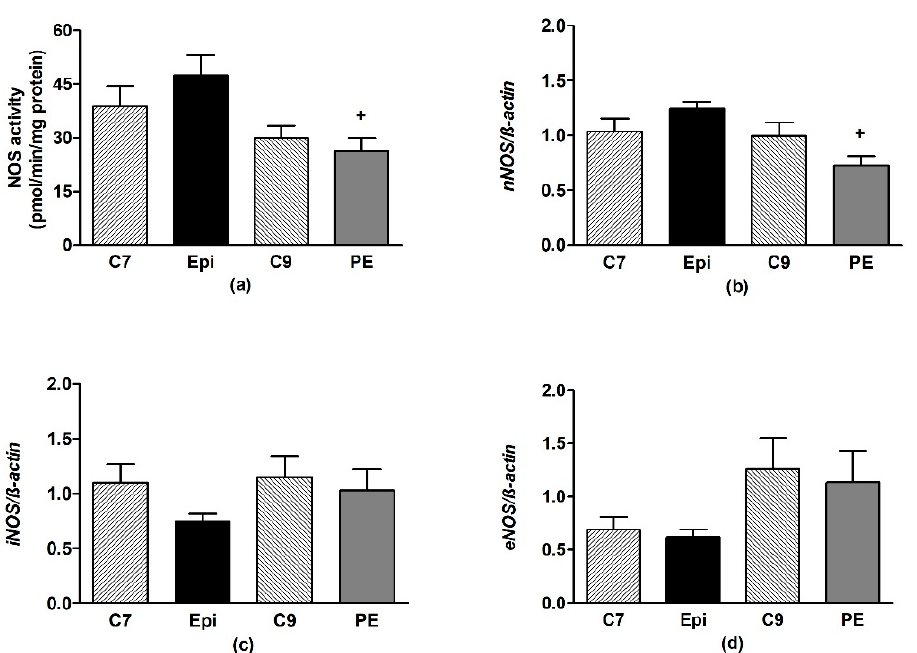
Figure 7. The effect of (–)-epicatechin on the nitric oxide synthase (NOS) activity ( a ) and gene expression of neuronal nNOS ( b ), inducible iNOS ( c ) and endothelial eNOS ( d ) in the brainstem of borderline hypertensive rats. The values represent the mean ± SEM. + p < 0.05 vs. Epi group.